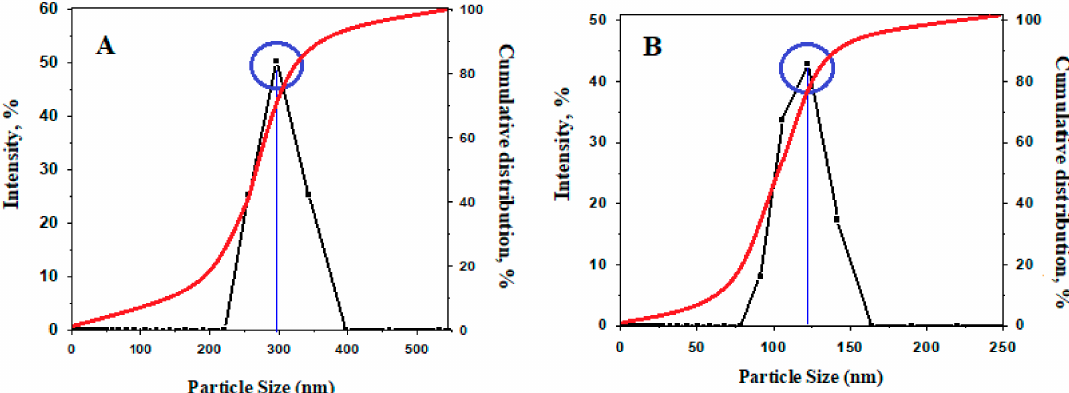
Figure 6. The relative and cumulative particle size distributions of naked Fe 3 O 4 nanoparticles ( A ) and the FPVAFU- ZLDH ( B